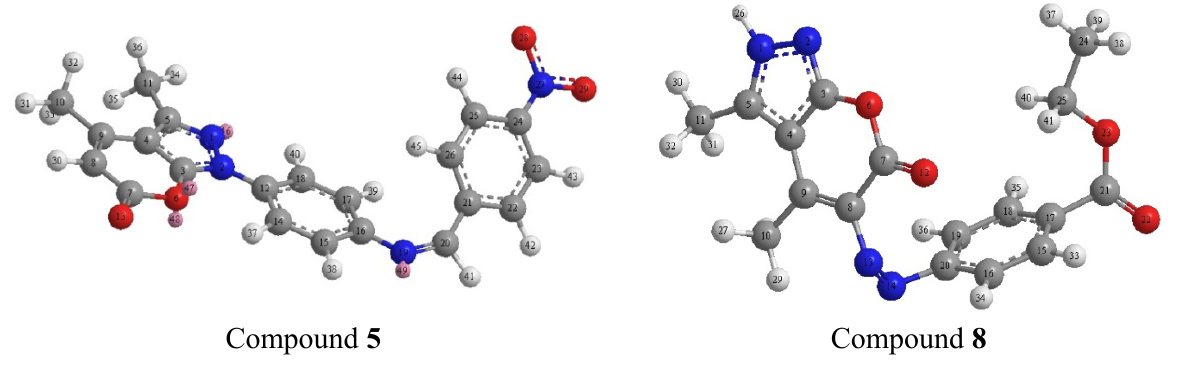
Figure 1. Optimized 3D geometrical structures for compounds 5 and 8